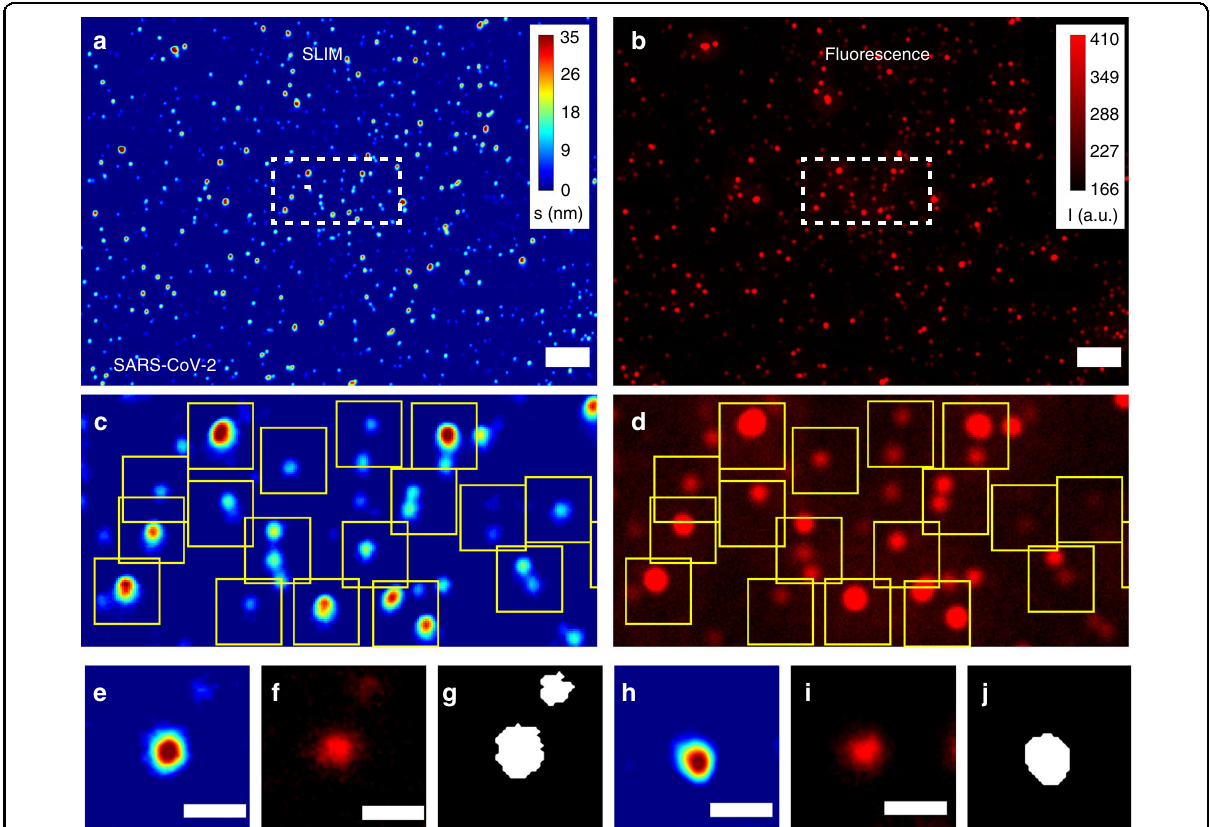
Fig. 3 Correlated SLIM- fl uorescence imaging results for SARS-CoV-2. a SLIM, colorbar represents optical path-length fl uctuations in nm, and b fl uorescence image, colorbar represents intensity in a.u., for the same fi eld of view. c, d Cropped SLIM and fl uorescence images from the region inside the white rectangle in a and b , yellow boxes highlight the correspondence between SLIM and fl uorescence. e One 48 × 48 cropped image of SLIM, f fl uorescence, and g corresponding segmentation mask prepared for AI. Another cropped set for h SLIM, i fl uorescence, and j segmentation mask. Scale bar represents 5 μ m for a, b and 1 μ m for e –